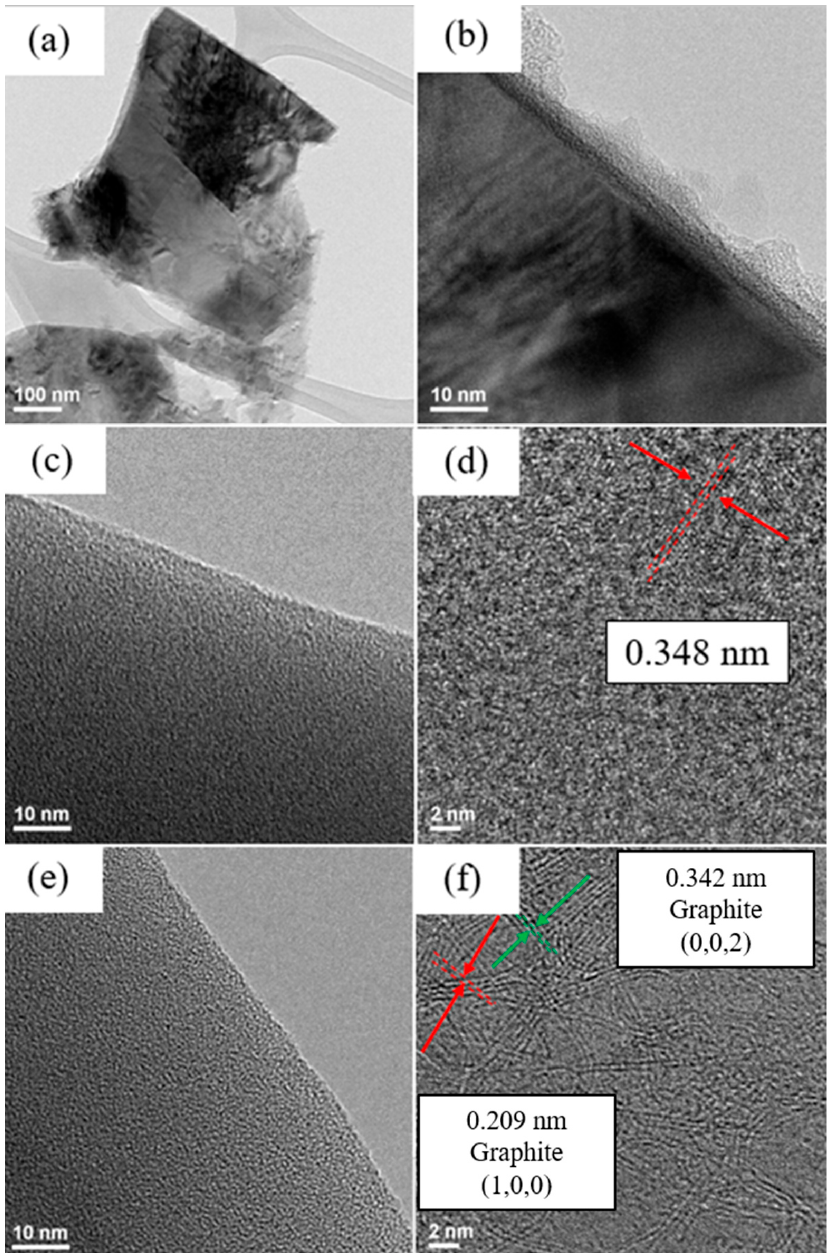
Figure 4. TEM images of ( a , b ) pristine silicon flakes, ( c ) pristine CMC, ( d ) pyrolytic CMC, ( e ) pristine SBR, and ( f ) pyrolytic SBR.